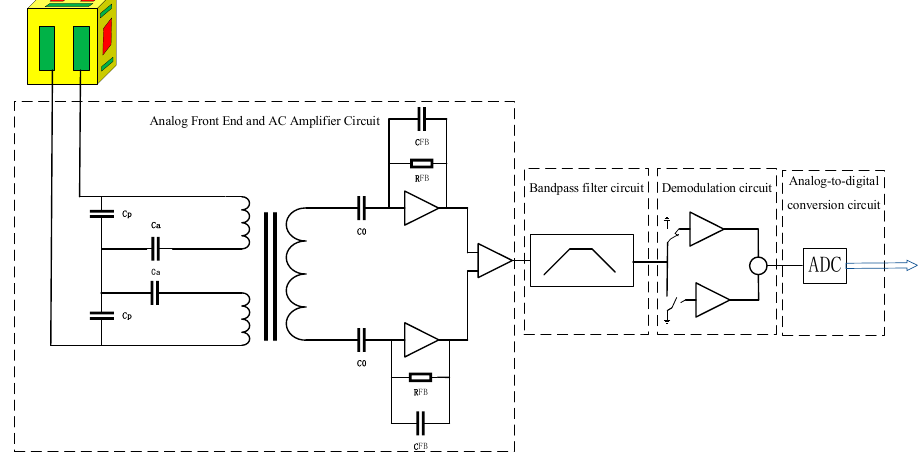
Figure 2. Block diagram of the single TM ‐ sensing channel electronics along the x ‐ axis. Figure 2 is a block diagram of the single TM ‐ sensing channel electronics along the x ‐ axis, with the remaining channels omitted for simplicity. Two pairs of electrodes (A+/A − , B+/B − ) allow simultaneous measurement of TM displacement and rotation by measuring the gap between the electrodes on opposite sides of the TM. For small TM displacements, the capacitance is proportional to the corresponding TM electrode gap. An AC ‐ excitation signal is injected into the TM. The differential current that is amplified and converted to an AC ‐ induced voltage proportional to the TM displacement is filtered at the AC ‐ excita ‐ tion frequency, and the final amplitude is demodulated and converted to a DC voltage digital value. The capacitive sensing system circuit includes an analog front ‐ end and an AC ‐ amplifier circuit, a band ‐ pass filter circuit, a demodulation circuit, an analog ‐ to ‐ digital conversion circuit, and a total of four functional module circuits. Similarly, the other eight electrodes (not shown) were used to derive TM motion. The TM is surrounded by four sense/drive electrodes on each axis. A stable 1 00 kHz AC signal was applied to the TM through the red excitation ‐ injection electrode in Figure 1. The elec ‐ trode pair A+/A − is defined as the first sensing channel of the x ‐ axis, and the electrode pair B+/B − is defined as the second sensing channel of the x ‐ axis. To overcome the need to specify different position sensing requirements for each axis (displacement or rotation), the requirement is to convert to capacitance and have an equal range on all axes (chan ‐ nels), i.e., scientific measurement resolution of 5.8 fF . The range is (cid:3399) 0.12 pF for the mode and (cid:3399) 2.5 pF for the wide ‐ range (WR) mode. The capacitive sensing noise of the key tech ‐ nical indicators is required to be measured in the scientific measurement (HR) mode, so this paper focuses on the scientific measurement (HR) mode. 2.1. Equivalent Sensitive Structure for Torsion Balance Equivalent test masses for torsion balances are at the heart of mechanically sensitive structures. It is an equivalent cube with a side length of 46 mm and a mass of about 107 g , made of platinum, gold, and aluminum alloys.